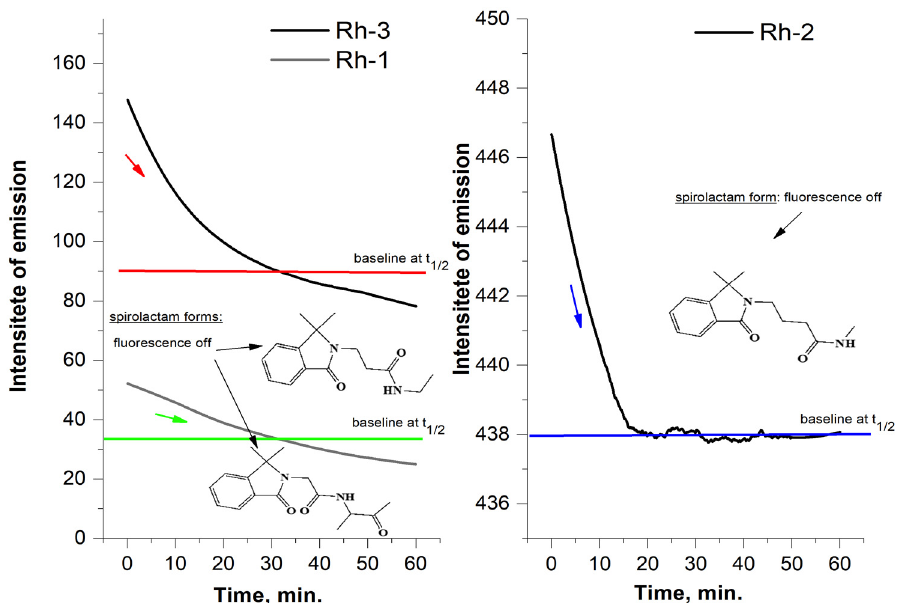
Figure 7. Fluorescence kinetic plot of the first-order reaction between ring-opened and formed of the spirolactam form at equal concentration of Rh-1, Rh-2 and Rh-3 and 25 °C.